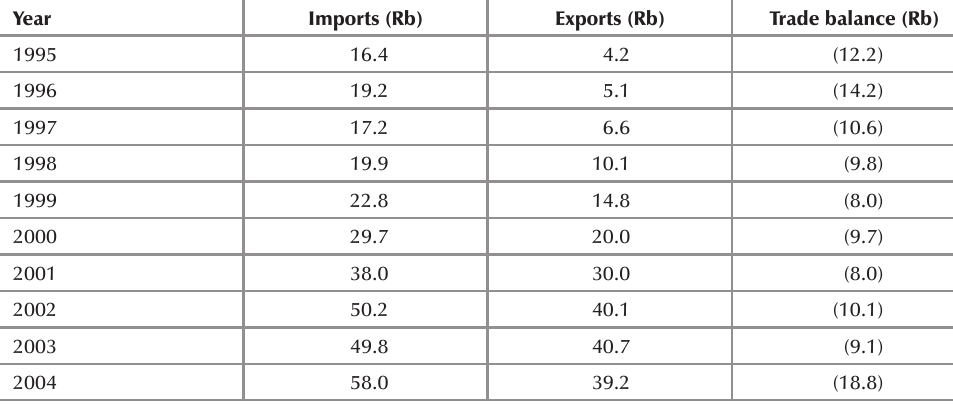
South Africa’s total automotive industry trade balance (R billion),